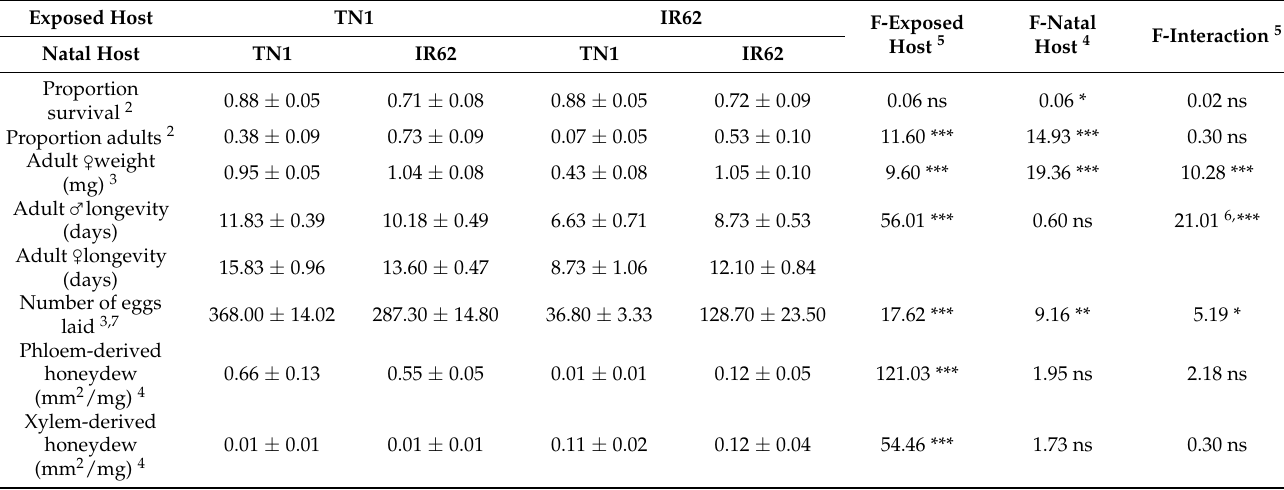
Table 1. Baseline parameters for virulent (natal host = IR62) 1 and avirulent (natal host = TN1) 1 planthoppers following exposure to IR62 and TN1 hosts. Means ± standard errors are